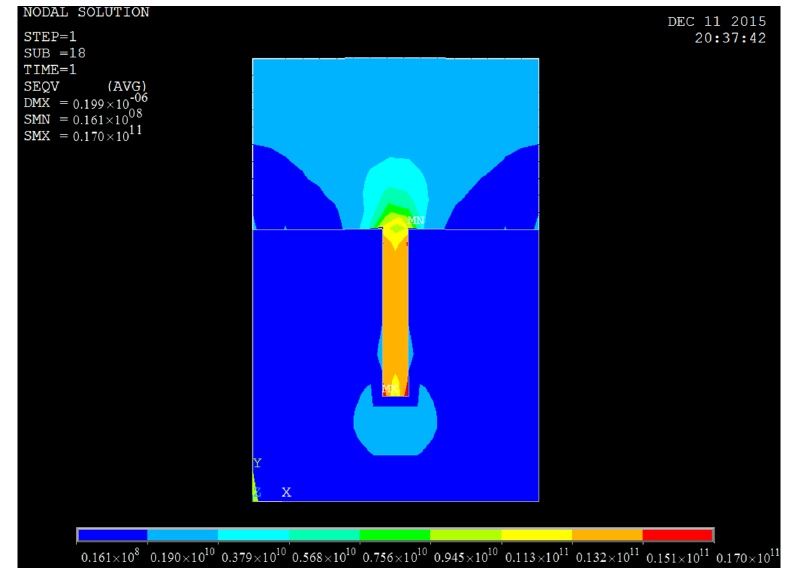
Figure 7. Von Mises stress distribution for a positive mold with an aspect ratio of 7:1, and the corresponding resist.